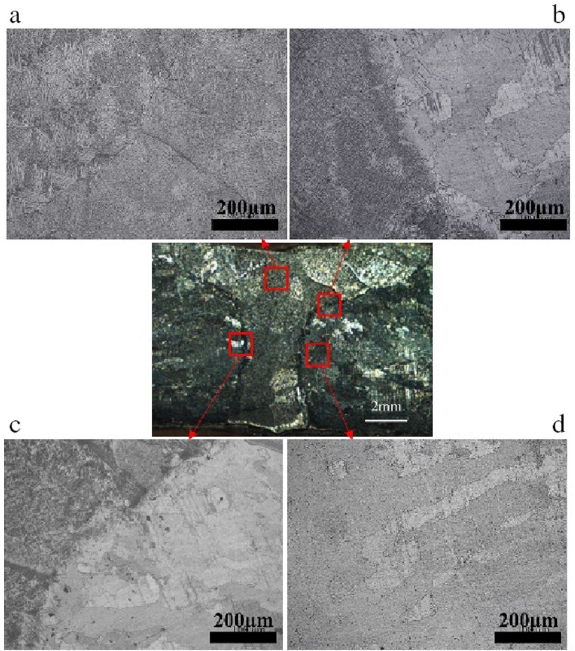
Figure 4. Microstructure of the TA2 side. ( a ) Weld, ( b ) fusion zone, ( c ) fusion zone and ( d ) HAZ zone.